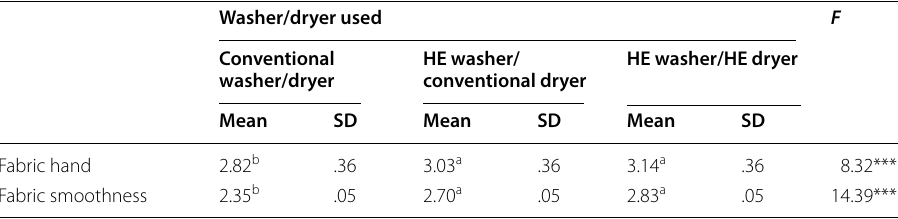
Fabric hand was evaluated by a rating of 1 to 5. “5” indicates “much softer than the standard unwashed fabric,” “3” indicates “as the standard unwashed fabric,” and “1” indicates “much rougher than the standard unwashed fabric” Fabric smoothness was evaluated by a rating of 1 to 5. “5” indicates the best performance (i.e., smooth without any wrinkle) *** p <